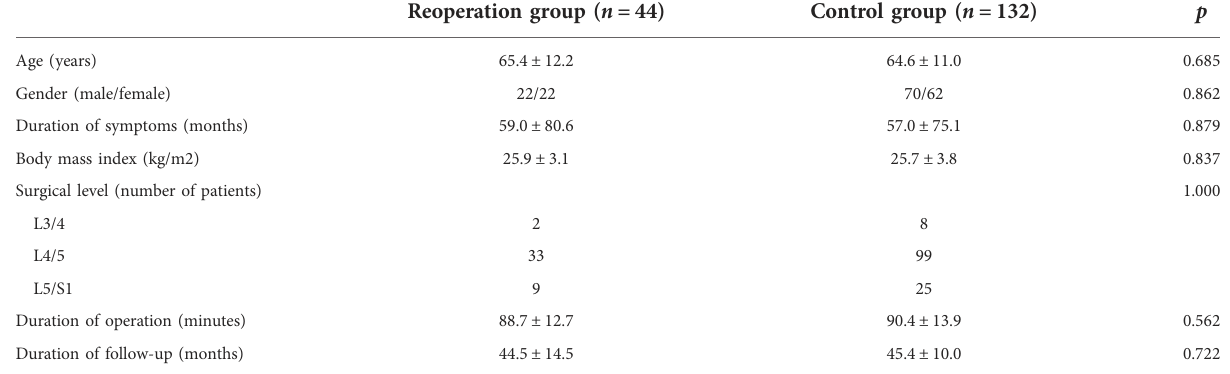
TABLE 2 Demographic and clinical characteristics of the included